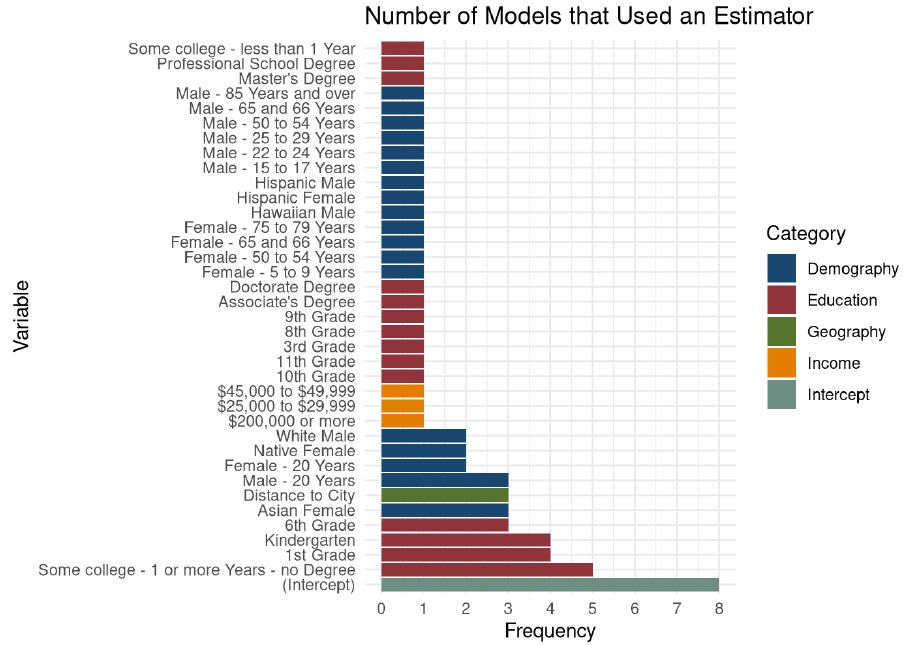
Figure 5. Predictors most frequently included in the regression models. The color coded categories were added to aid